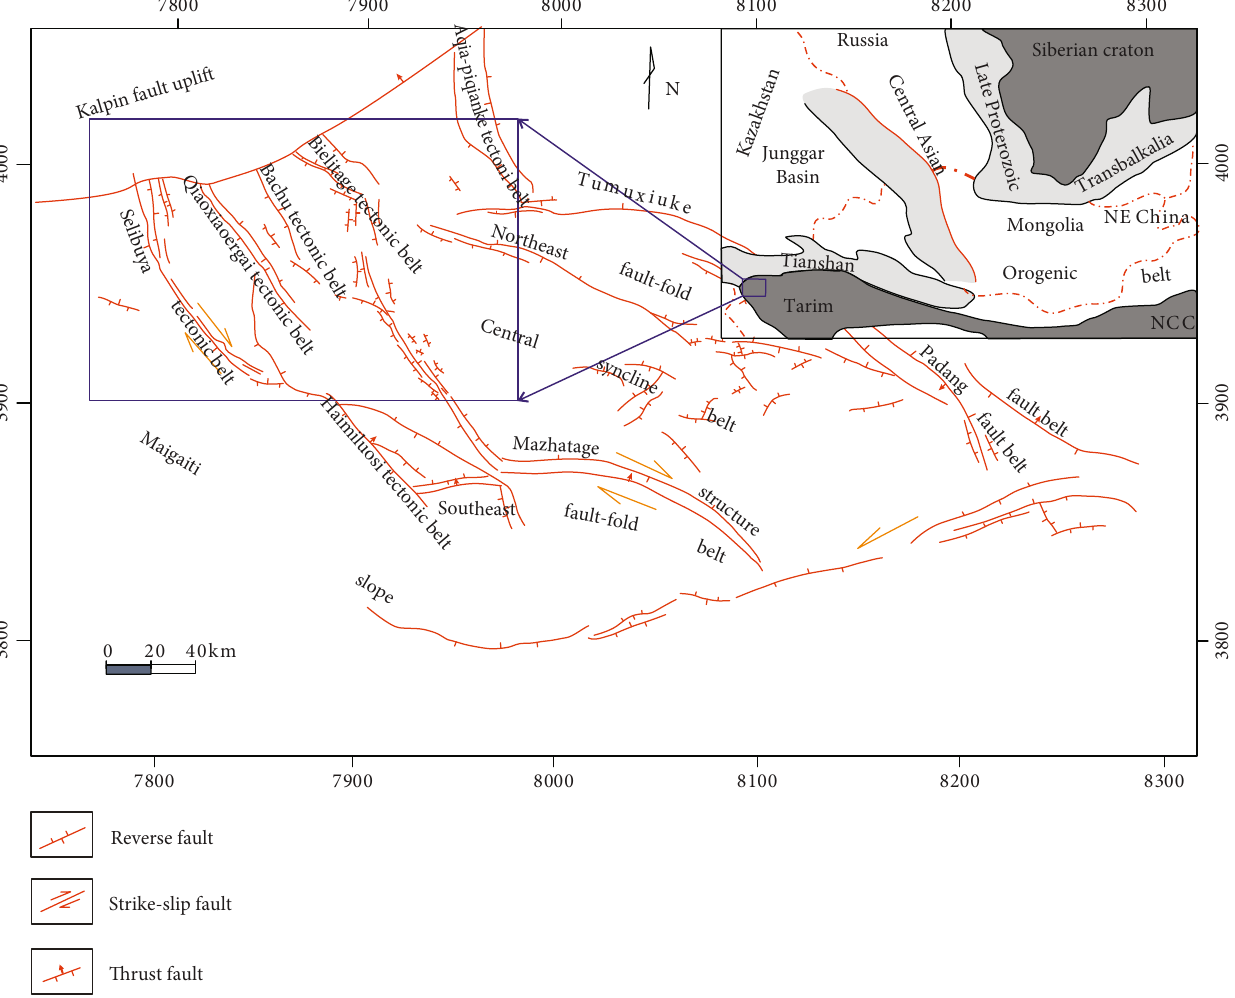
Figure 1: Generalized map showing the location and the distribution of tectonic units in the Tabei Outcrop